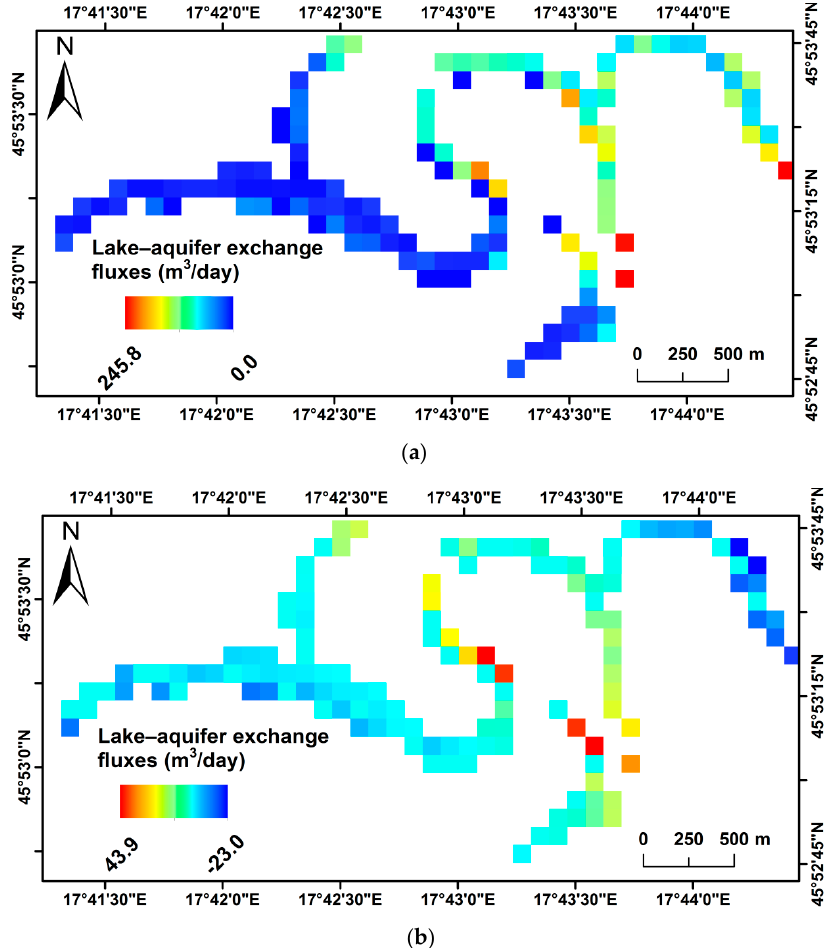
Figure 12. Lake–aquifer exchange fluxes for the Korcsina reservoir: ( a ) at the end of filling period of 14 days (+2 m reservoir stage), ( b ) for 40 days of discharge period (+1 m) (positive represents upward reservoir seepage gain and negative represents downward reservoir seepage loss).